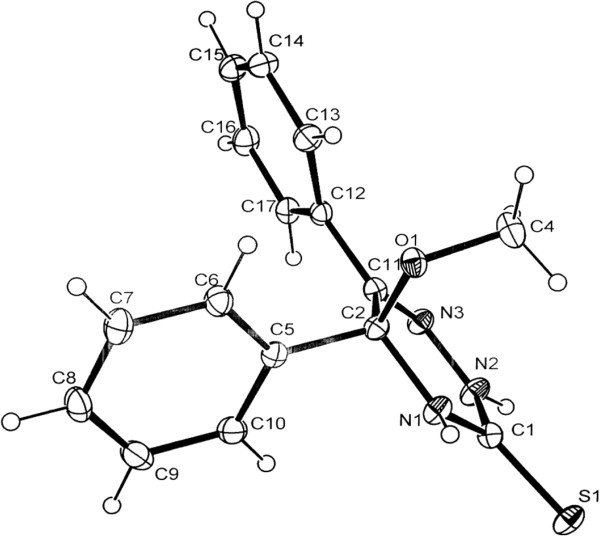
The ORTEP diagram triazine-3-thione of 5-Methoxy-5,6-diphenyl-4,5-dihydro-2H-1,2,4- triazine-3-thione.